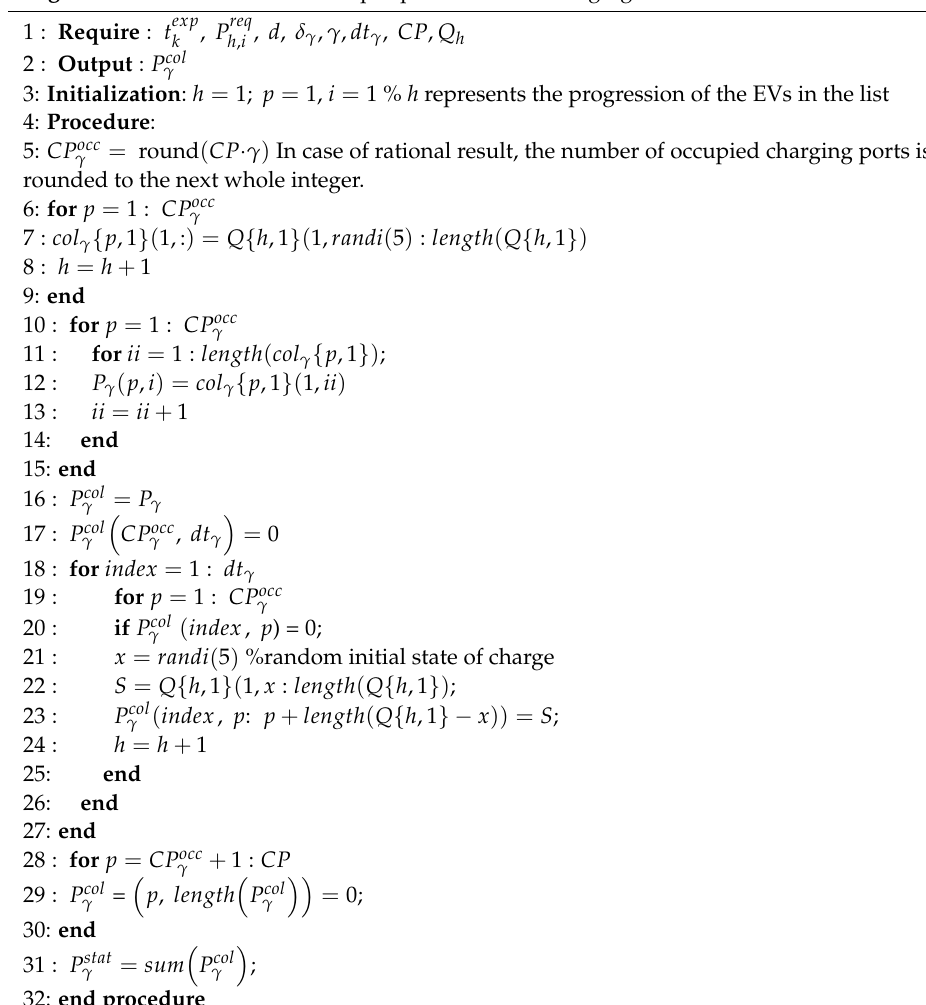
Algorithm 3 Estimation of the output power of each charging